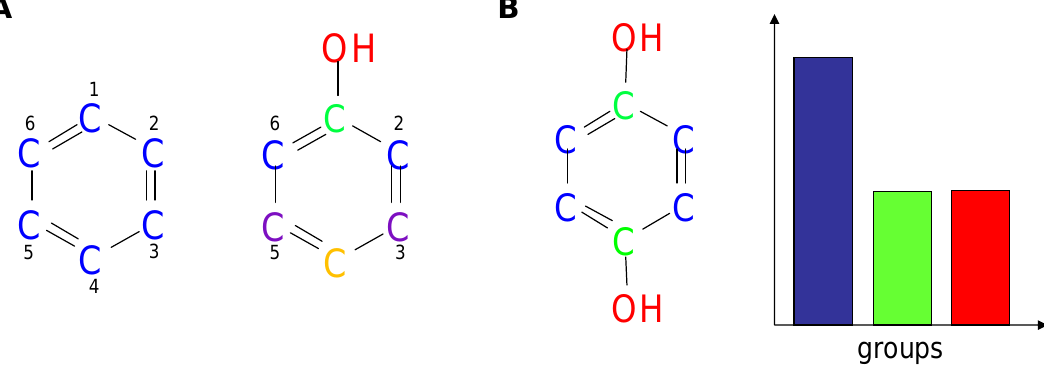
Figure 2. Partitioning of atoms into sets of indistinguishable atoms. Atoms of a molecule are grouped together if they are topologically indistinguishable. For each molecule, atoms belonging to the same group are shown in the same color. (a) All (non-hydrogen) atoms of benzene are indistinguishable. When a hydroxyl group is added, the carbons in positions 2 and 6 as well as those in positions 3 and 5 positions are indistinguishable, as indicated by the color code. (b) For benzene-1,4-diol, groups of indistinguishable atoms are shown in the same color and the probability distribution resulting from the partitioning is